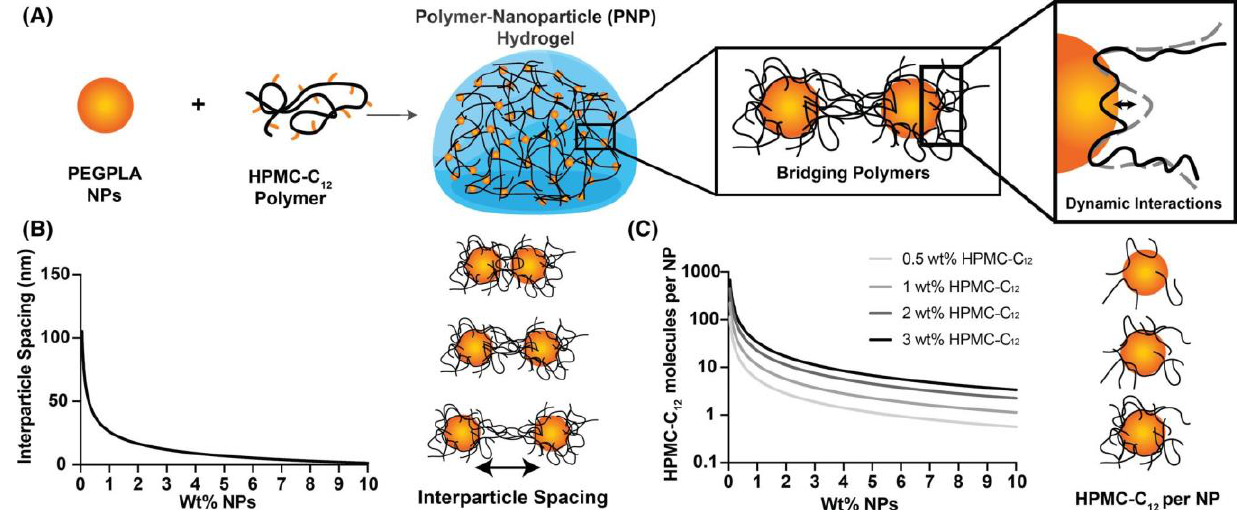
Figure 2. ( A ) Hydrogels formed through the interactions of PEG – PLA nanoparticles (NPs) and dodecyl-modified hydroxypropyl methylcellulose polymers (HPMC-C12). Polymers bridge between polymers and dynamically interact with the NP surface. ( B ) Average interparticle spacing of NPs as a function of the weight percentage of NPs added. ( C ) Number of molecules of HPMC-C12 per NP as a function of the concentration of NPs and concentration of polymer. Reproduced from reference [75], an open access article distributed under the terms of Creative Commons CC BY license, which permits unrestricted use, distribution and reproduction in any medium, provided the original work is properly cited.